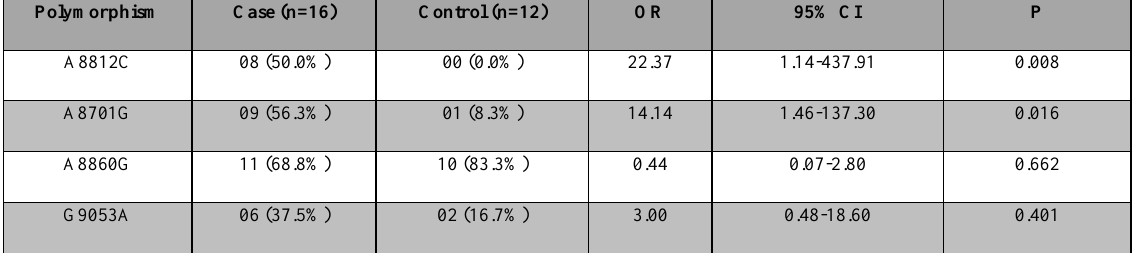
Table 1. Genotype frequencies of ATPase6 gene polymorphisms in cases and controls.